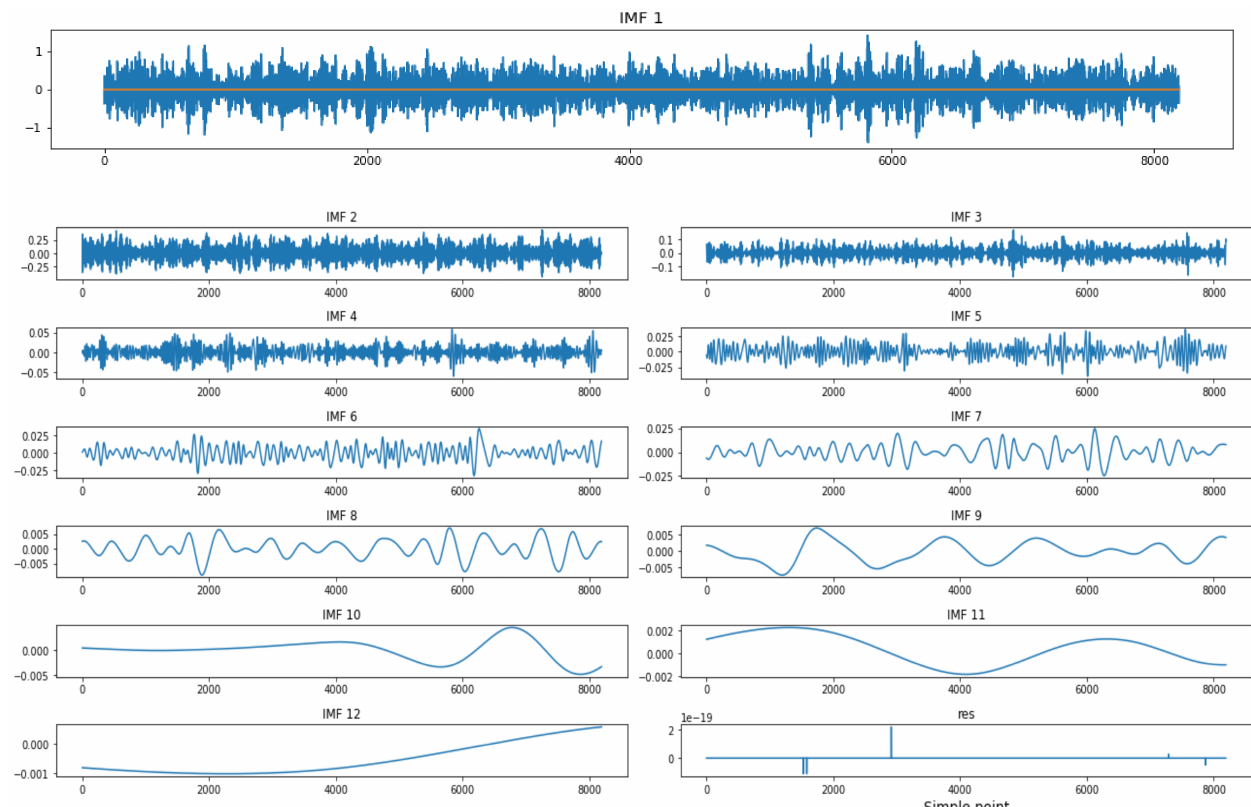
Figure 11. Results of decomposition for A_3 acceleration data sets.